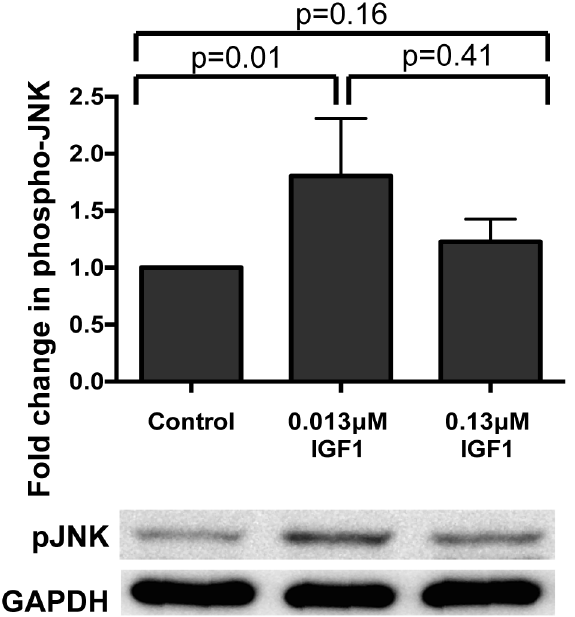
Figure 1. Ingested human IGF1 increased JNK phosphorylation in A.stephensi midguts. Mosquitoes were fed blood meals containing 0.013 m M or 0.133 m M IGF1 or an equivalent volume of PBS. Midguts were dissected at 0.5–1 h after the initiation of blood feeding. Data are represented as the average fold induction 6 SEM of phospho-JNK quantified by densitometry and normalized first to the GAPDH loading control and then to the buffer control. A representative western blot is shown below the graph. Data were analyzed by Mann Whitney test. Experiments were replicated four times and p-values are displayed on the